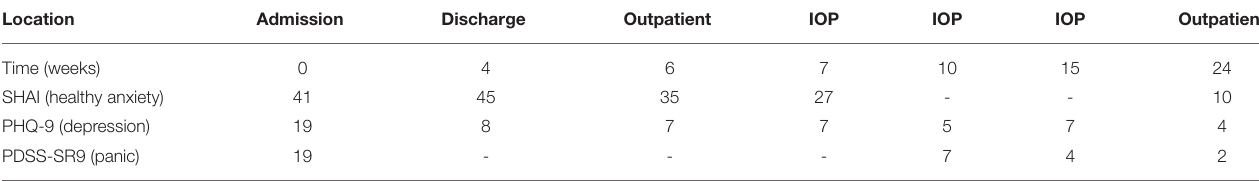
TABLE 1 | Patient’s scores on clinical symptom scales over time.